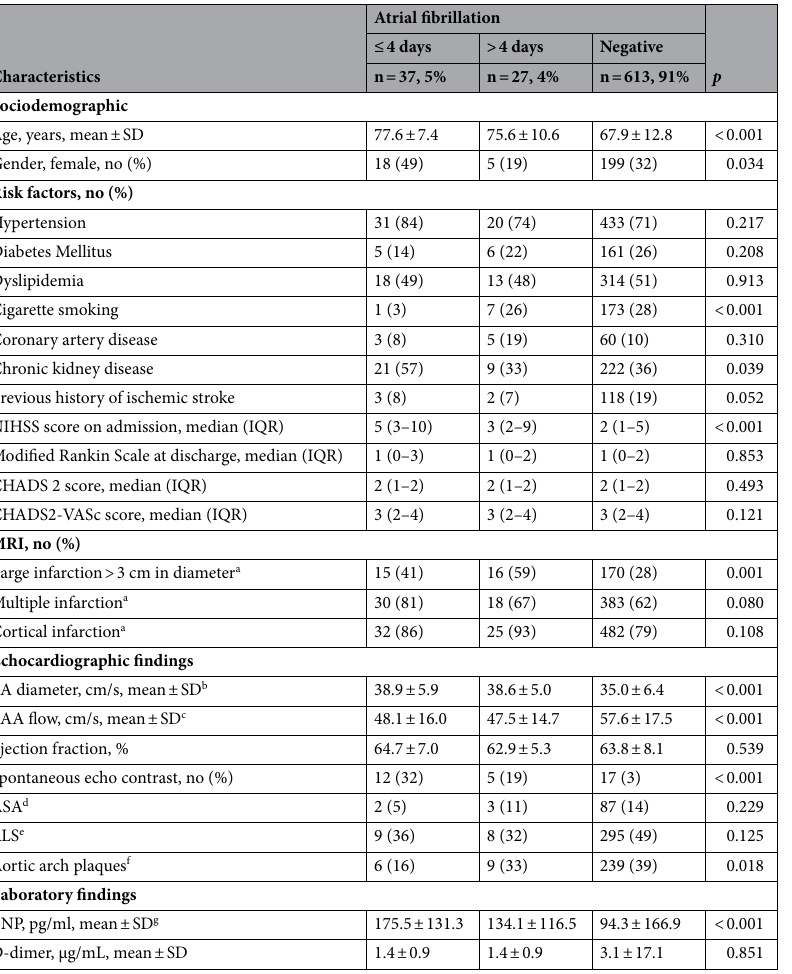
Table 1. Baseline characteristics, MRI and echocardiographic findings, and laboratory data in AF development ≤ 4 days and > 4 days, and none in the CHALLENGE ESUS/CS study population. Chi-square test, and the Kruskal–Wallis test were used for comparison. AF = atrial fibrillation; NIHSS = NIH Stroke scale; IQR = interquartile range; LA = left atrium; LAA = left atrial appendage; ASA = atrial septal aneurysm; RLS = right-to-left shunt; BNP = brain natriuretic peptide. Missing values: a n = 5; b n = 44; c n = 25; d n = 6; e n = 23; f n = 2; g n = 94. Chronic kidney disease was defined as eGFR < 60 mL/min/1.73 m 2 . LAA flow was defined an average of LAA inflow and out